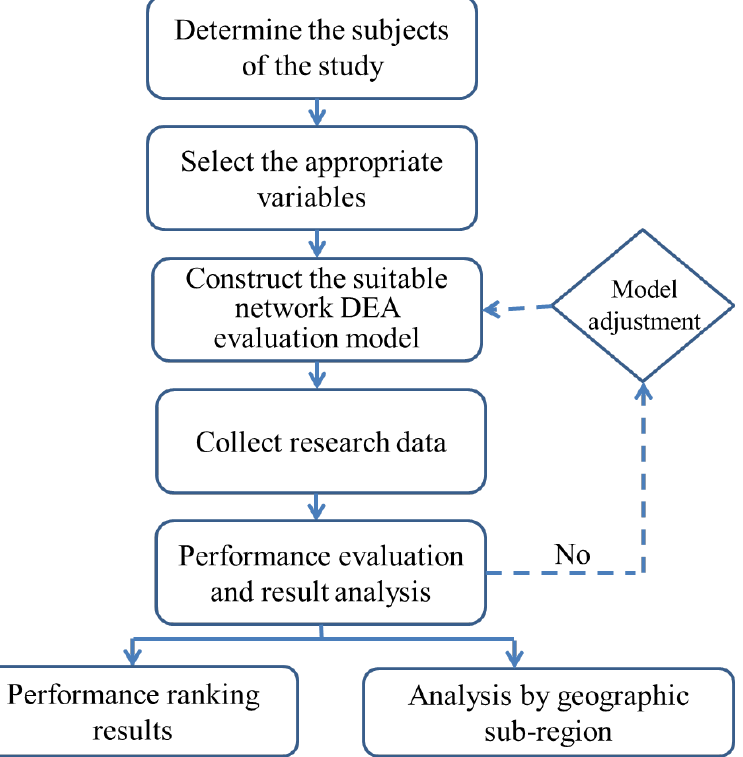
Figure 2. Flowchart for applying DEA model usage.